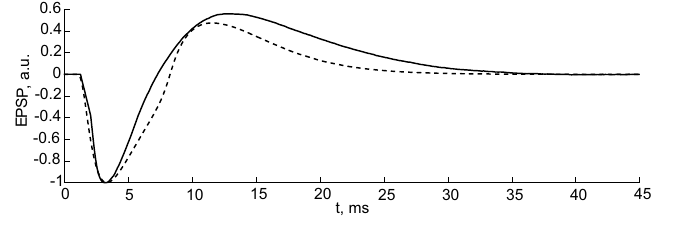
Figure 6. Comparison of experimental results (–) and model simulation ( − − − − − ). EPSPs from rat hippocampus slices were recorded as described in [27].